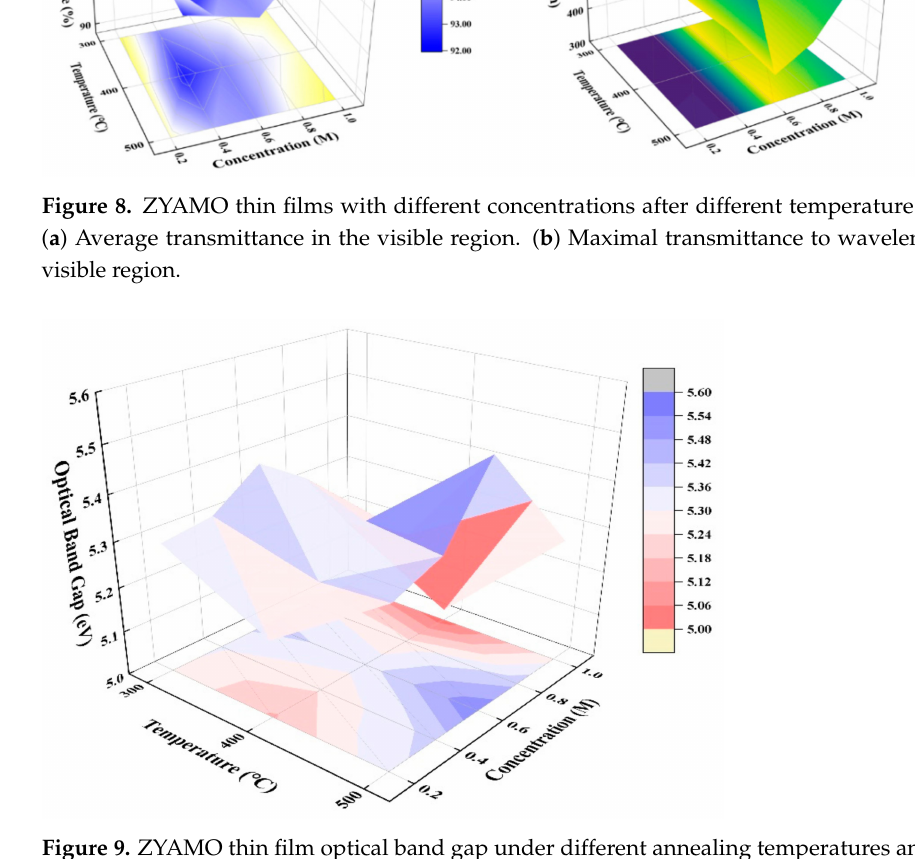
Figure 9. ZYAMO thin film optical band gap under different annealing temperatures and solution